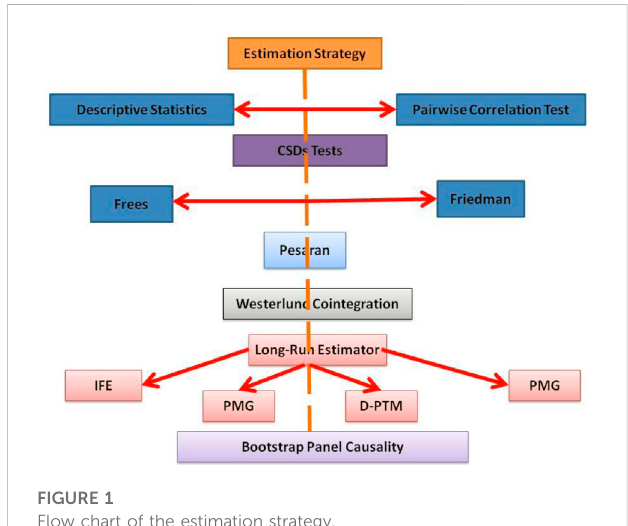
FIGURE 1 Flow chart of the estimation